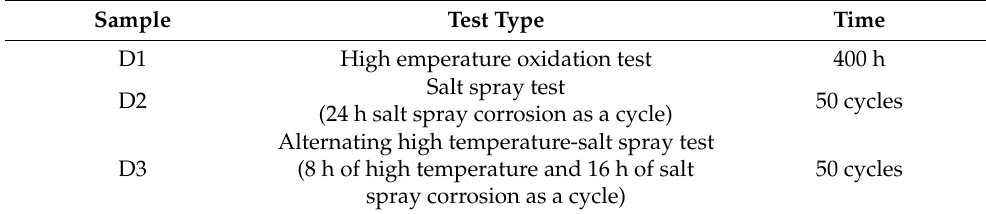
Figure 2. Diagram of the test equipment: ( a ) High temperature oxidation test; ( b ) Salt spray test; ( a , b ) Alternating high temperature-salt spray test. ( a , b ) Alternating high temperature-salt spray test. Table 1. Details of the specific experimental design for Ti 2 AlNb Table 1. Details of the specific experimental design for Ti 2 AlNb alloy.